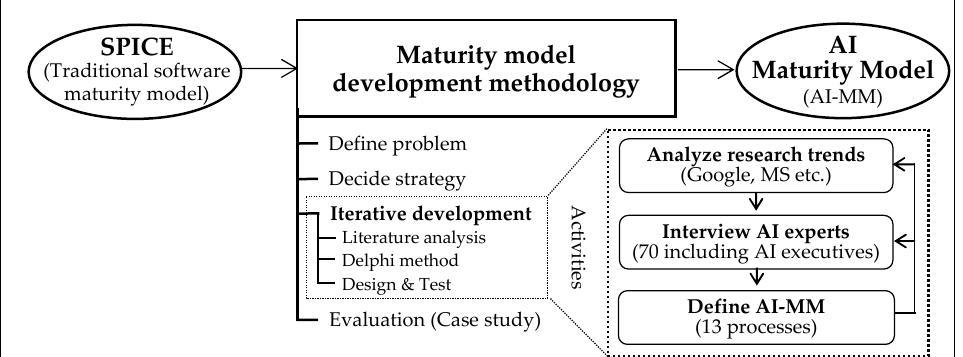
Figure 1. Development process of AI-MM (Becker et al. [27]) .